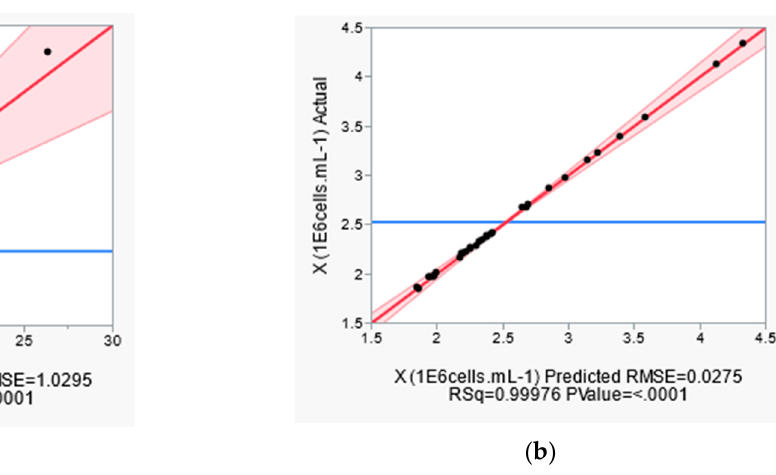
Figure 6. Actual by predicted plot of DoE simulations for ( a ) mAb, and ( b ) viable cell concentration. In the experimental design, the concentration in the reference medium was varied ± 50%. The significance of the parameters must therefore not be interpreted as generally valid, but only for the medium used. For both target parameters, the GLY concentration is the most significant parameter (see Figure 7). An important finding from the evaluations discussed above is not the fundamental dependence of cell growth and antibody produc- tivity on amino acid concentration, but the identifiability of those components that have a particularly sensitive effect in the process under investigation. Thus, the applicability of the model lies not only in the prediction of cultivation processes, but in the predictive optimization of media.